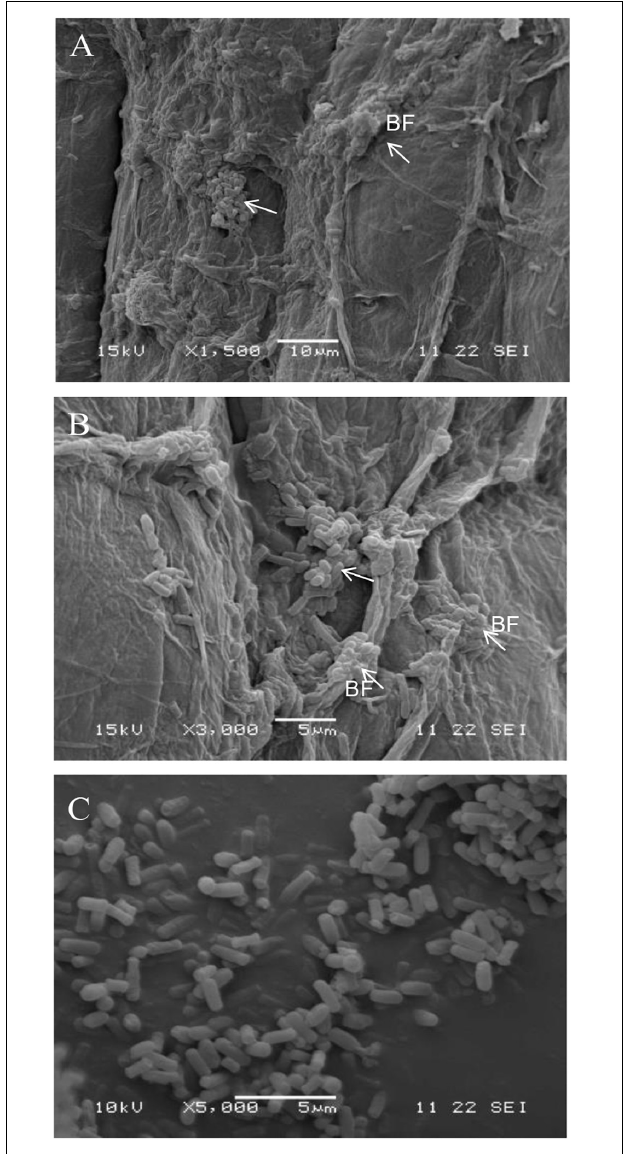
FIGURE 4 | Scanning electron micrograph (SEM) showing the surface colonization of cucumber root by strain B2 at × 1,500 (A) and × 3,000 (B) and strain B2 cells (C) . White arrow , bacteria; BF ,